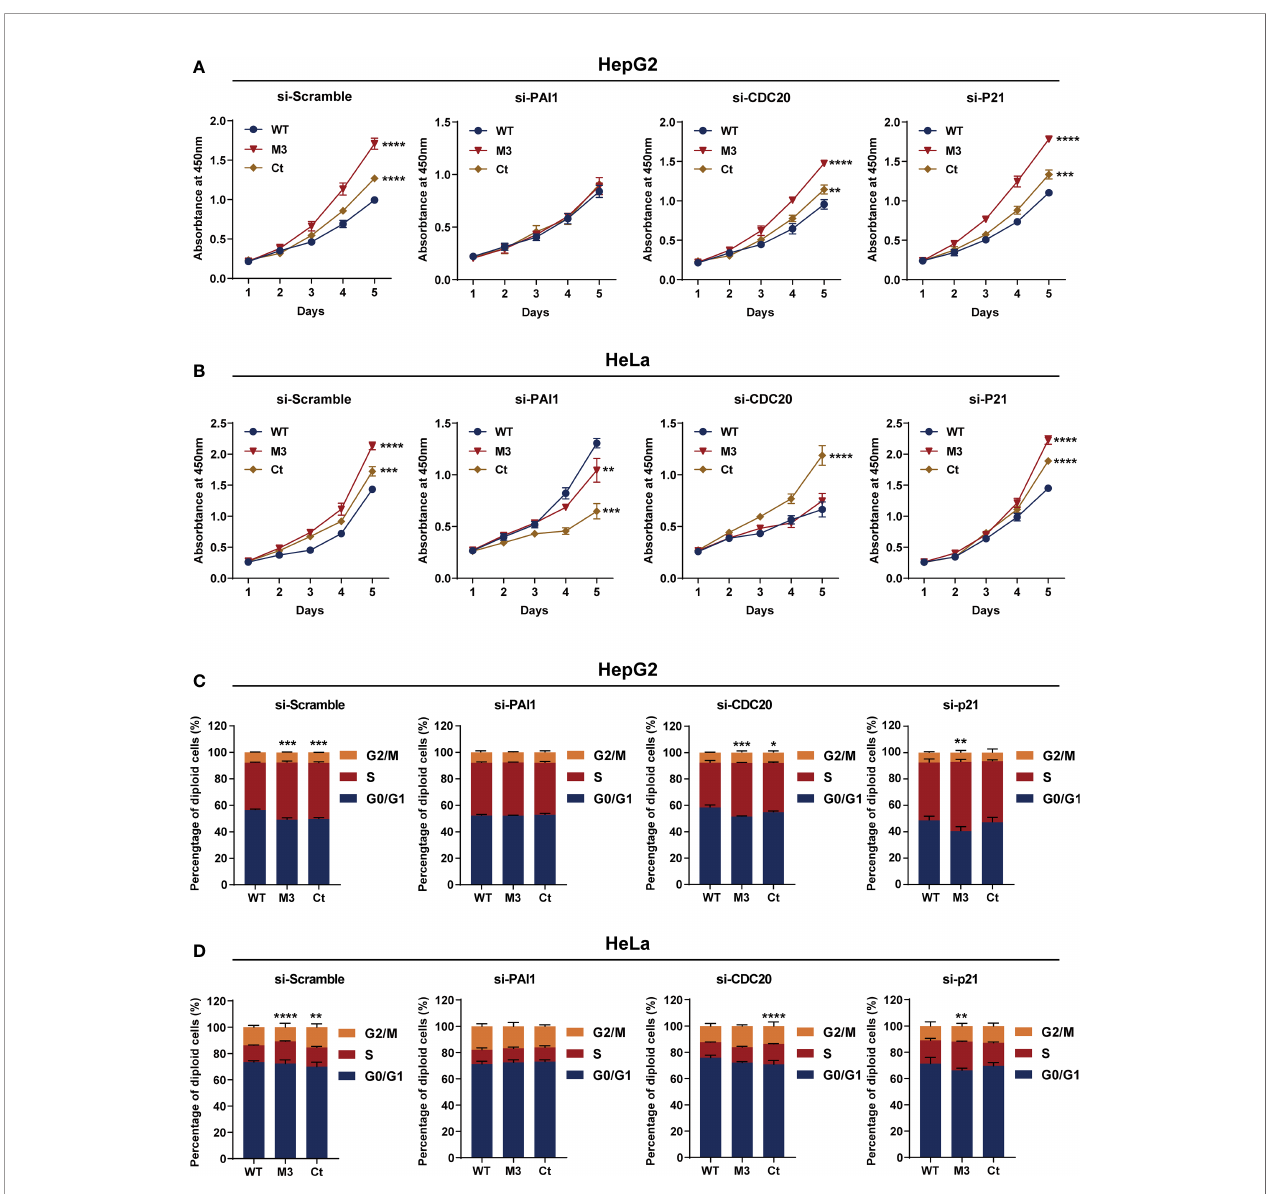
FIGURE 8 | Silencing functional molecules in fl uences the oncogenic effects of the HBx mutants. (A) Silencing PAI1, CDC20, and p21 in fl uences the effects of HBx mutants on the proliferation of HepG2 cells. (B) Silencing PAI1, CDC20, and p21 in fl uences the effects of HBx mutants on the proliferation of HeLa cells. (C) Silencing PAI1, CDC20, and p21 in fl uences the effects of HBx mutants on the cell cycle in HepG2 cells. (D) Silencing PAI1, CDC20, and p21 in fl uences the effects of HBx mutants on the cell cycle in HeLa cells. WT-HBx served as a control group in all comparisons. * P < 0.05; ** P < 0.01; *** P < 0.001; **** P <